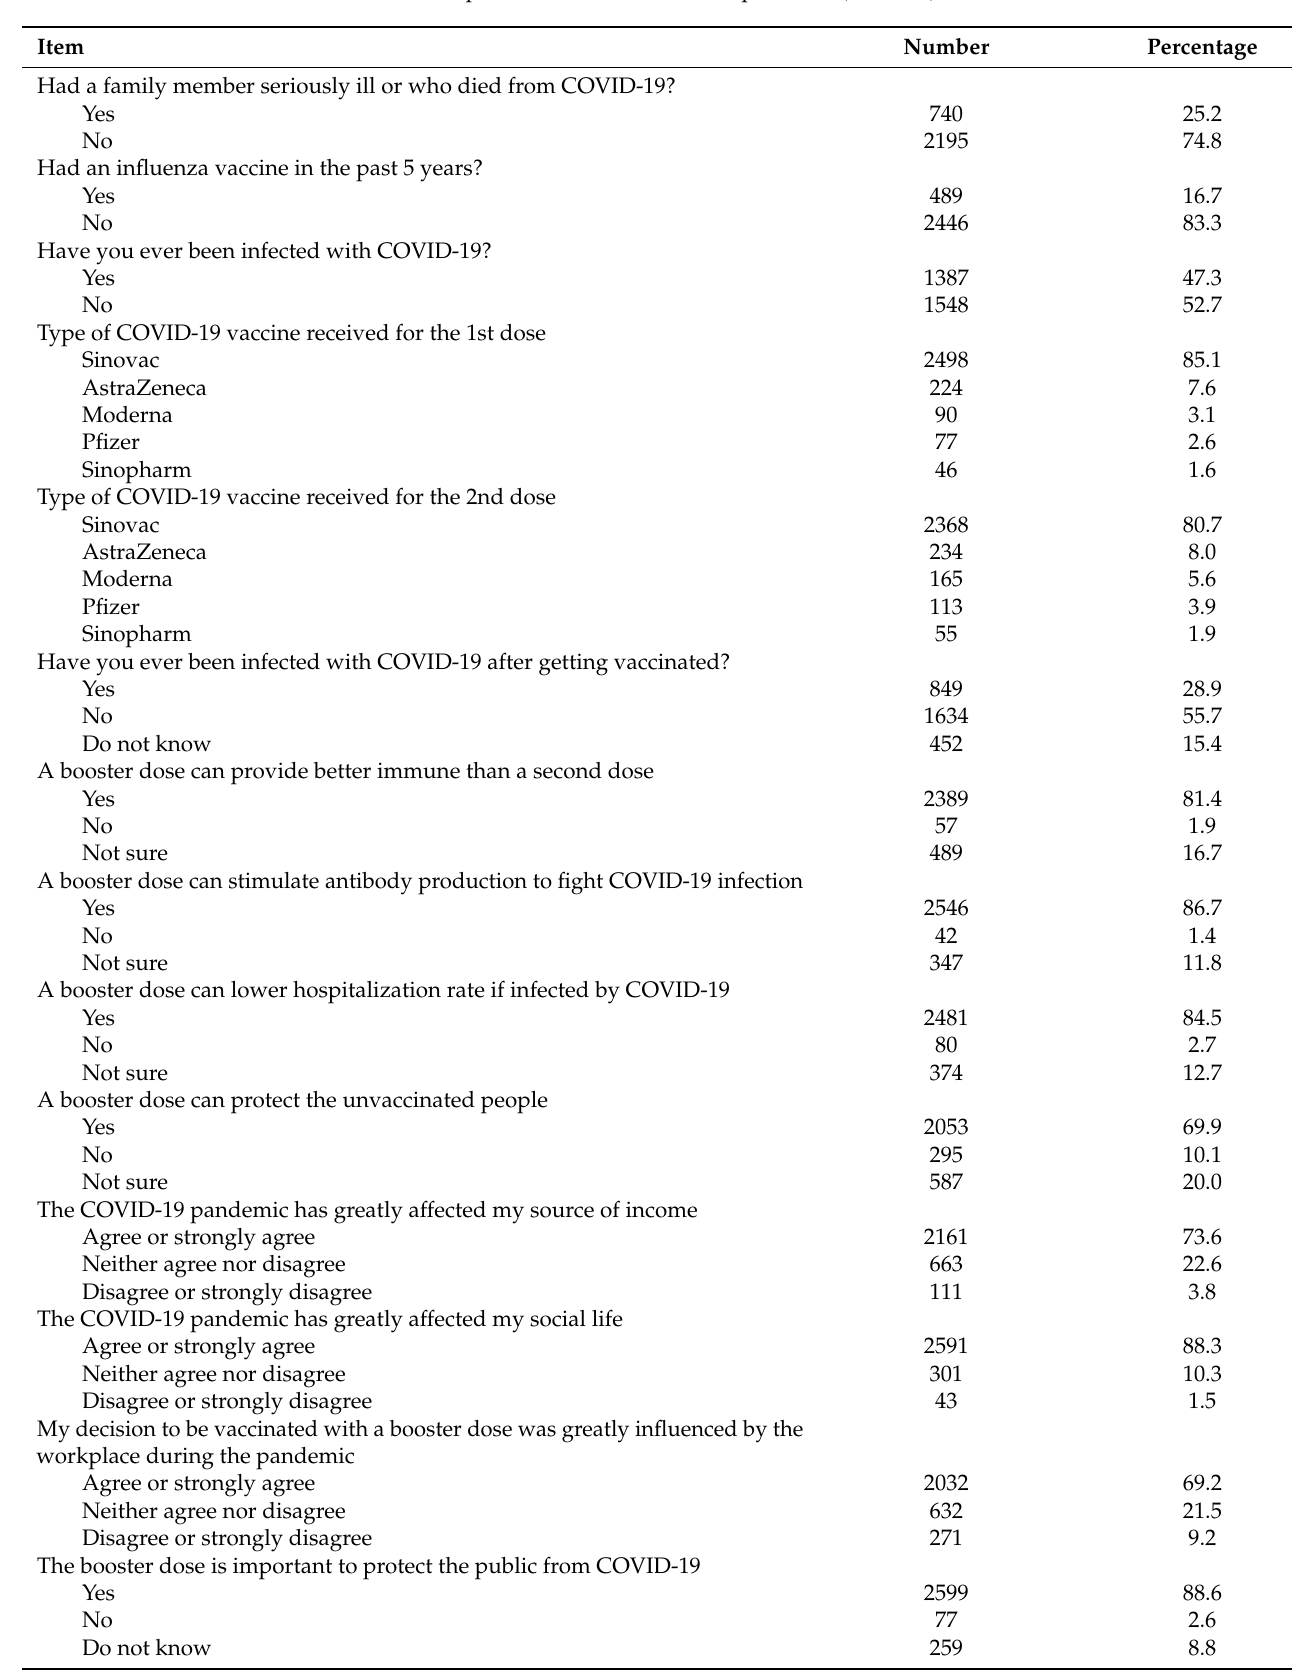
Table 2. Characteristics of the experience, knowledge, perception, perceived severity, perceived benefit and perceived barriers of the respondents ( n =